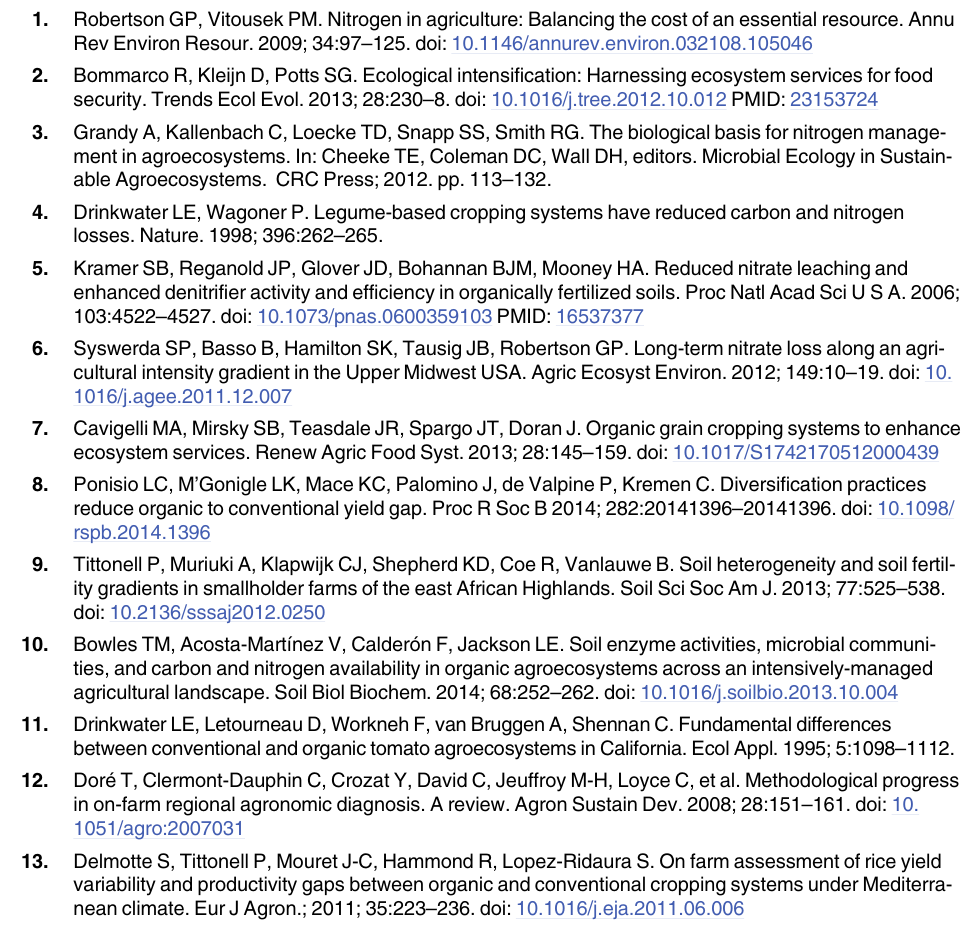
S2 Table. Soil inorganic N pools across all fields, times, and depths. Data are presented as back-transformed means (n = 6) ± 95% confidence intervals. S3 Table. Aboveground biomass and biomass N of organic Roma-type tomatoes. Data are from harvest sampling at the end of the 2011 growing